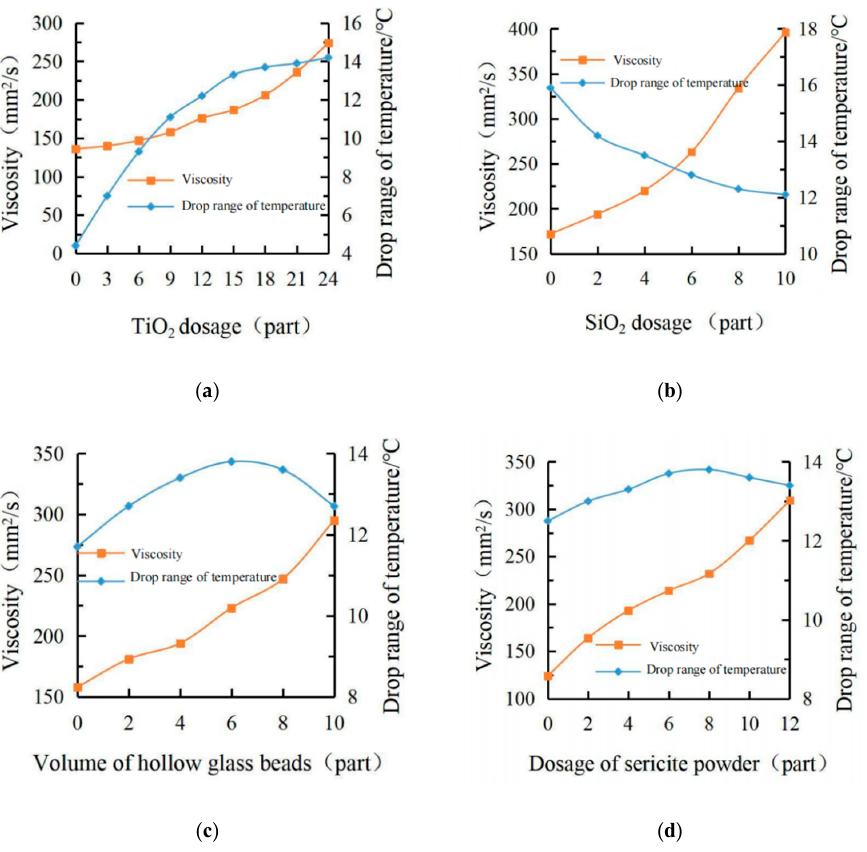
Figure 3. Effect of different fillers content on cooling value and viscosity. (a) Effect of different TiO2 contents on coatings, (b) Effect of different SiO2 content on coatings, (c) Effect of different content of hollow glass beads on Coatings, (d) Effect of different dosages of sericite powder on coatings.